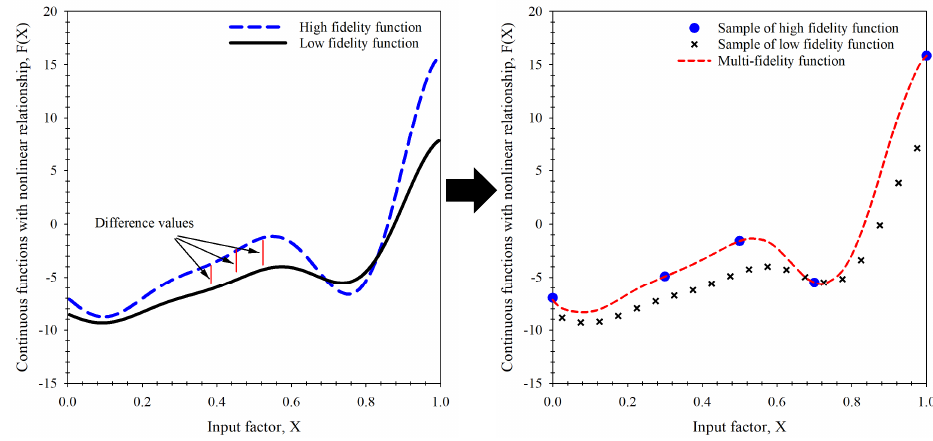
Figure 6. Concept of surrogate model for multi-fidelity function.